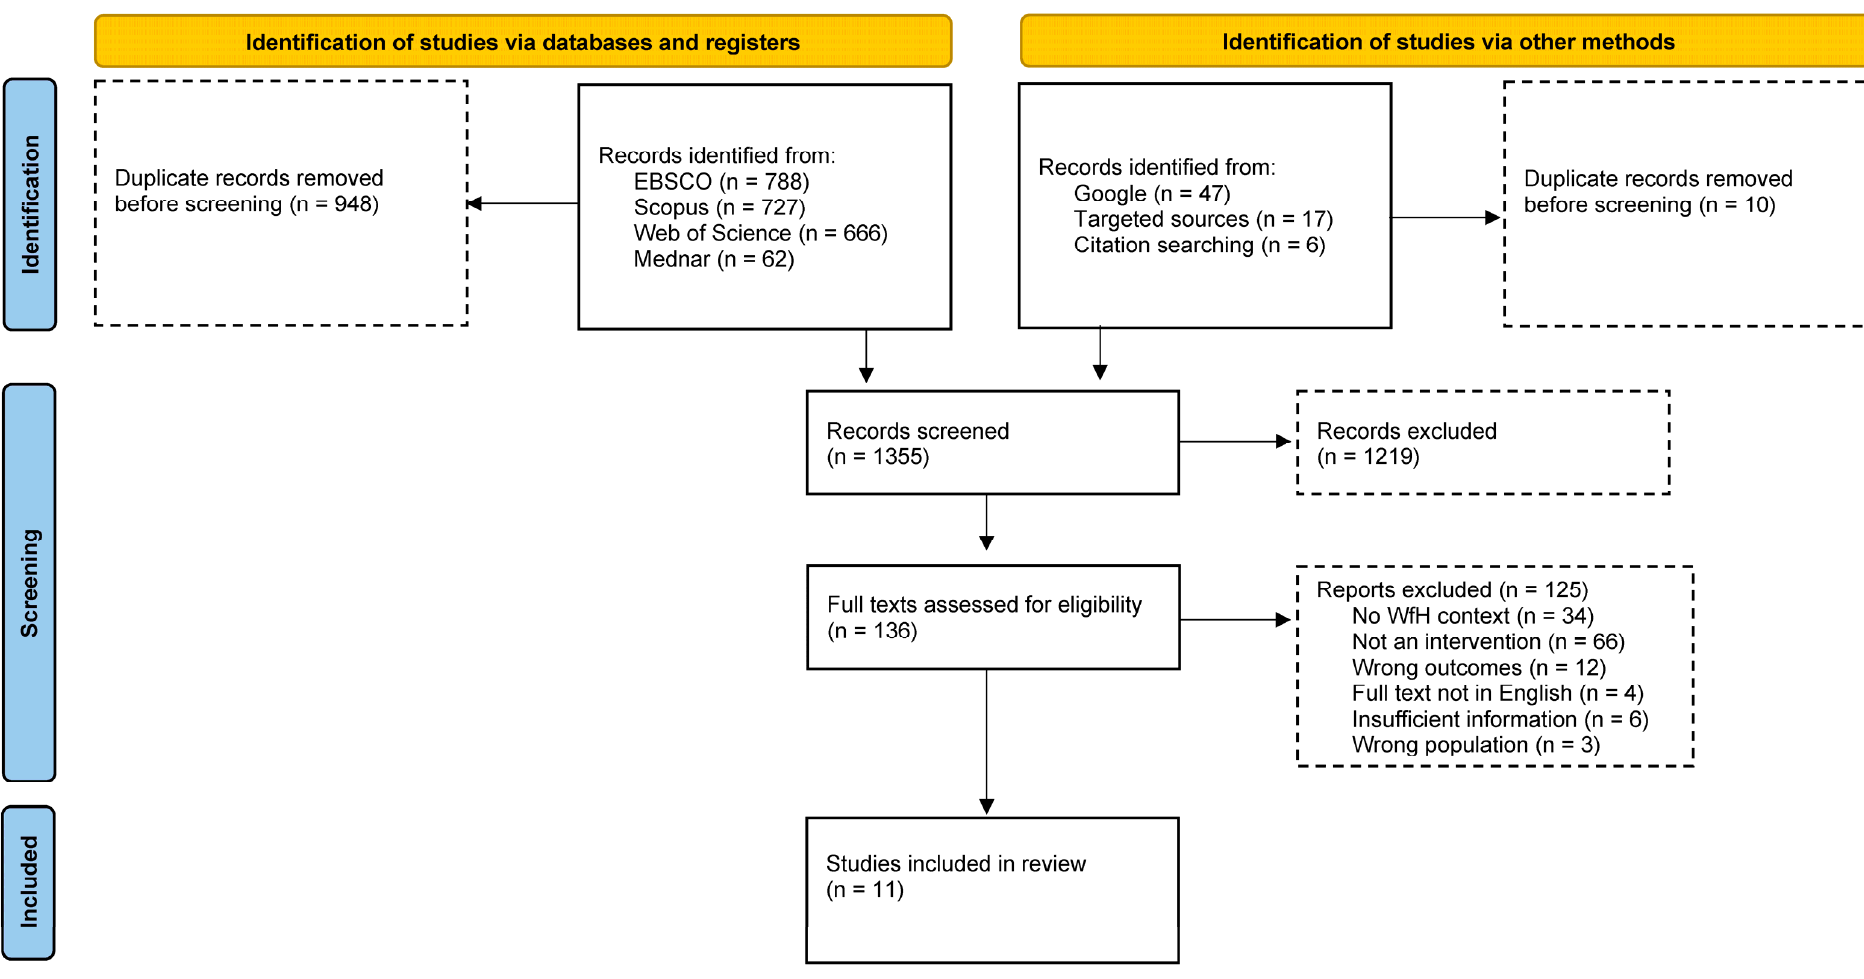
Figure 1. Flowchart of published and grey literature investigated.